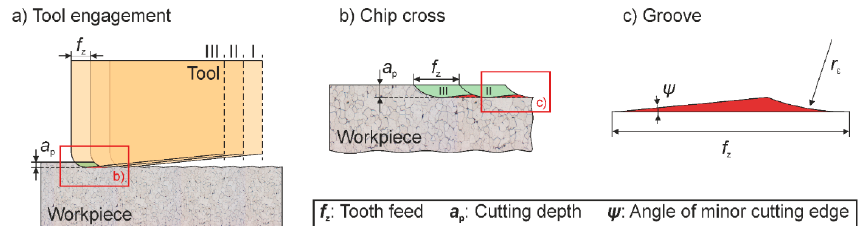
Figure 2. Schematic view on ( a ) a two dimensional engagement situation during milling, ( b ) two consecutive tooth feeds, ( c ) single milling marks with influencing parameters.